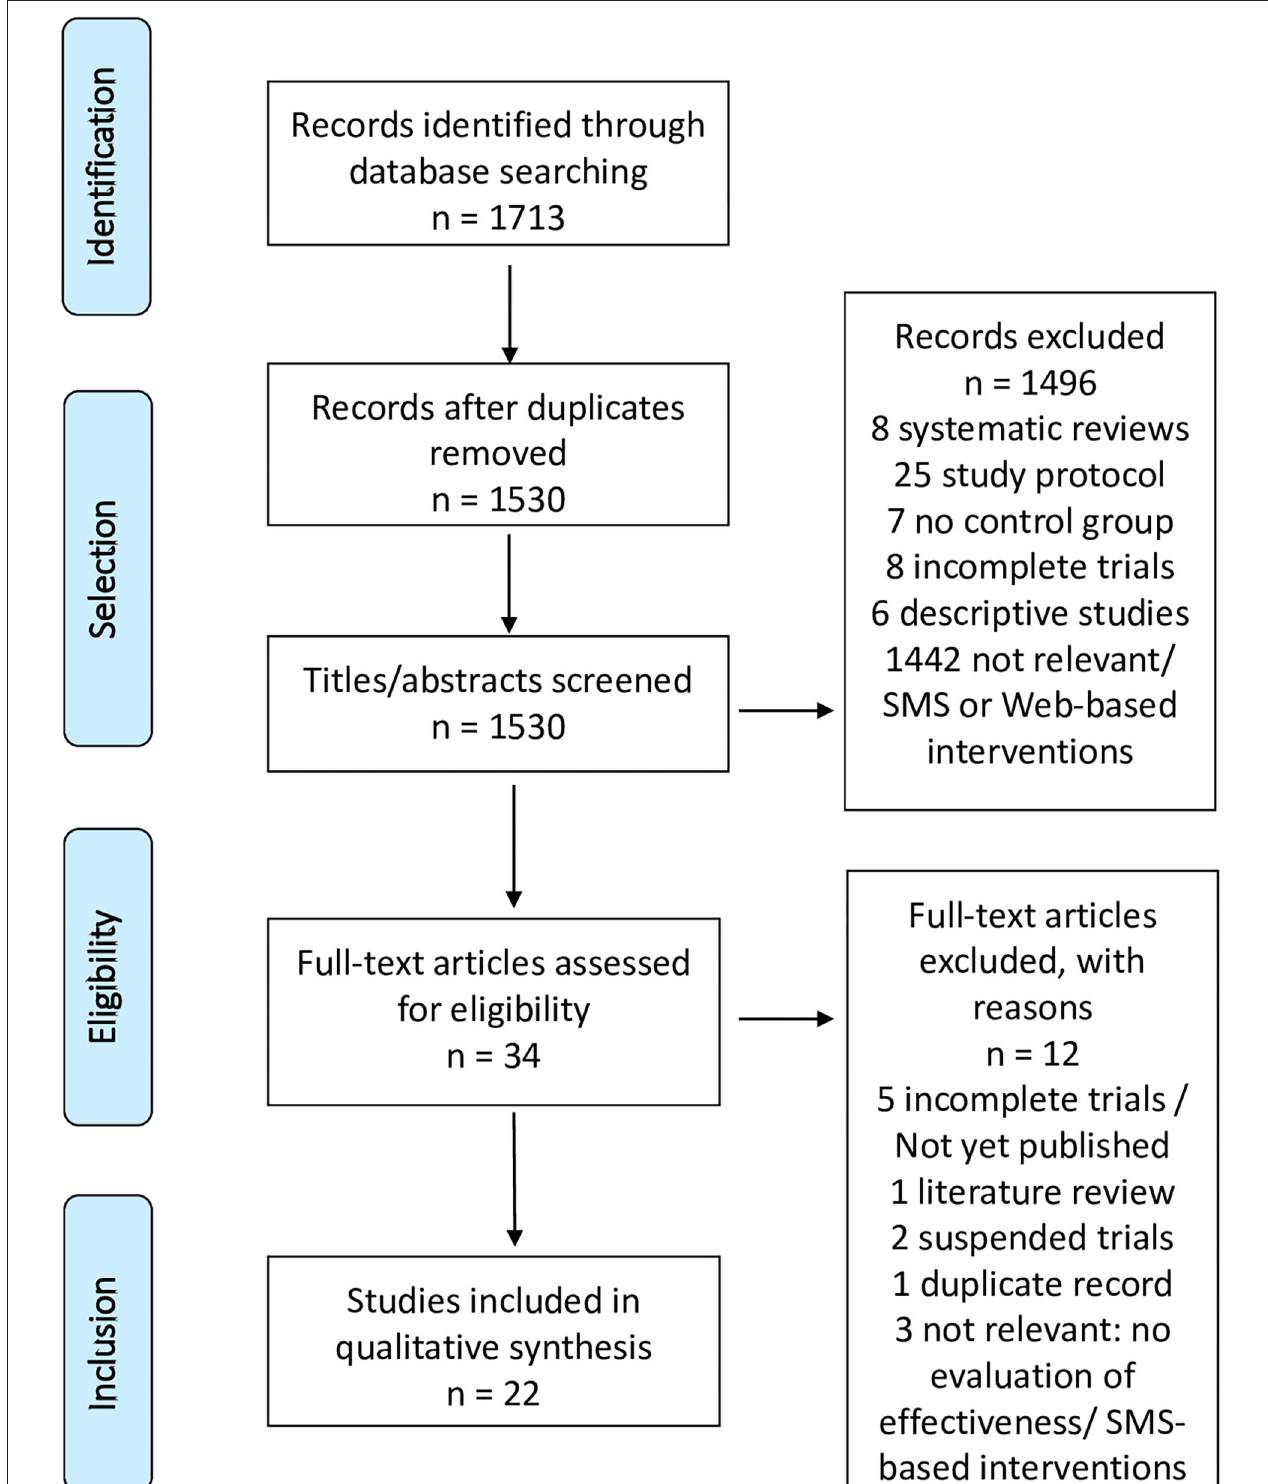
FIGURE 1 | PRISMA